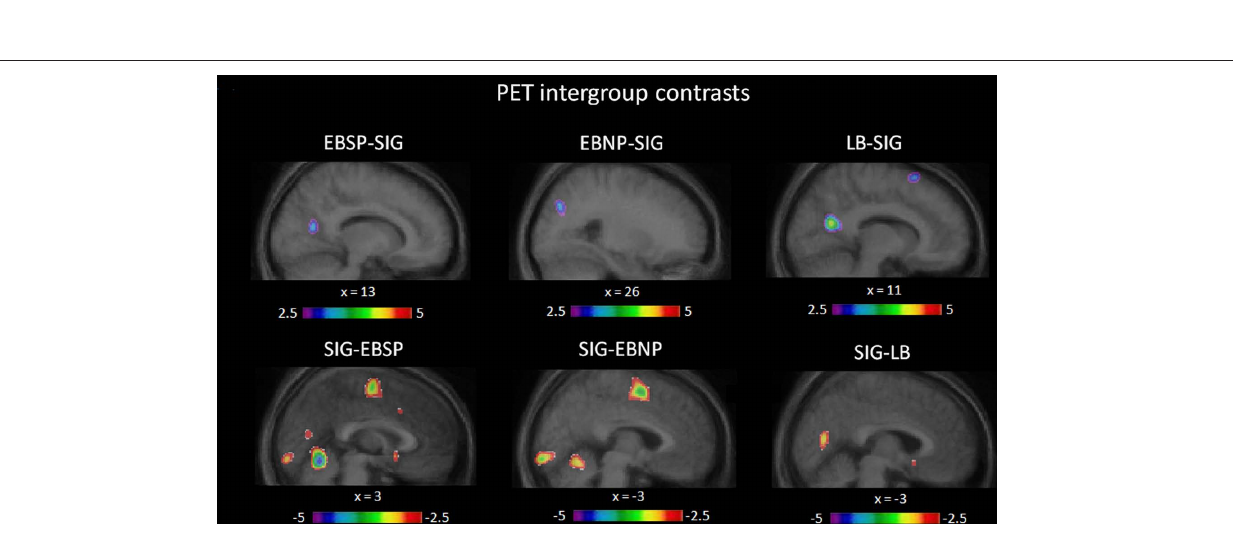
FigurE 4 | intergroup contrasts. Illustrated here are the differences in occipital activation between groups, relative to baseline, obtained via intergroup contrast analyses (see Table 2 for complete list of significant differentially activated